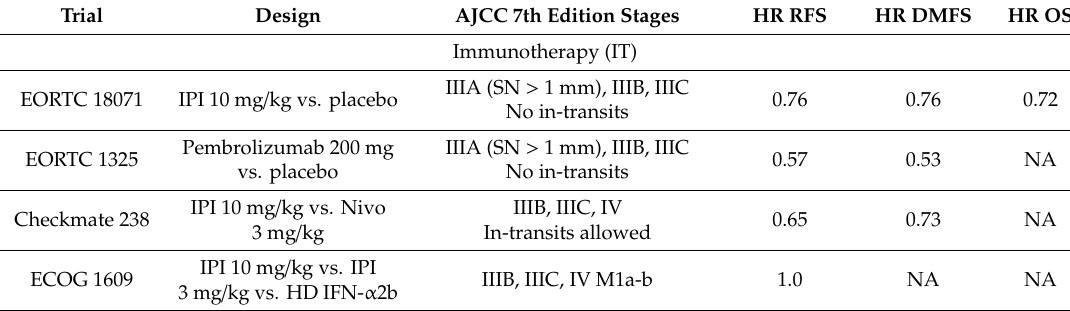
Table 1. Summary of the current landscape of adjuvant